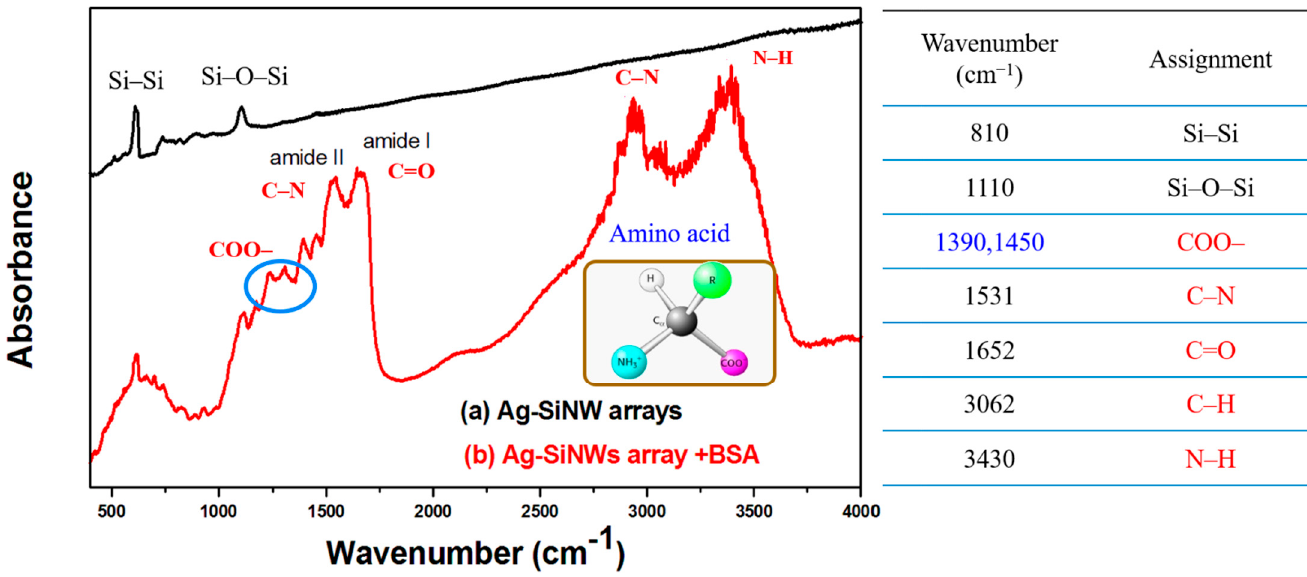
Figure 8. Comparison of FTIR spectra of the Ag–SiNW arrays ( a ) before the immobilization of BSA (black line) and ( b ) after immobilizing BSA (red line).